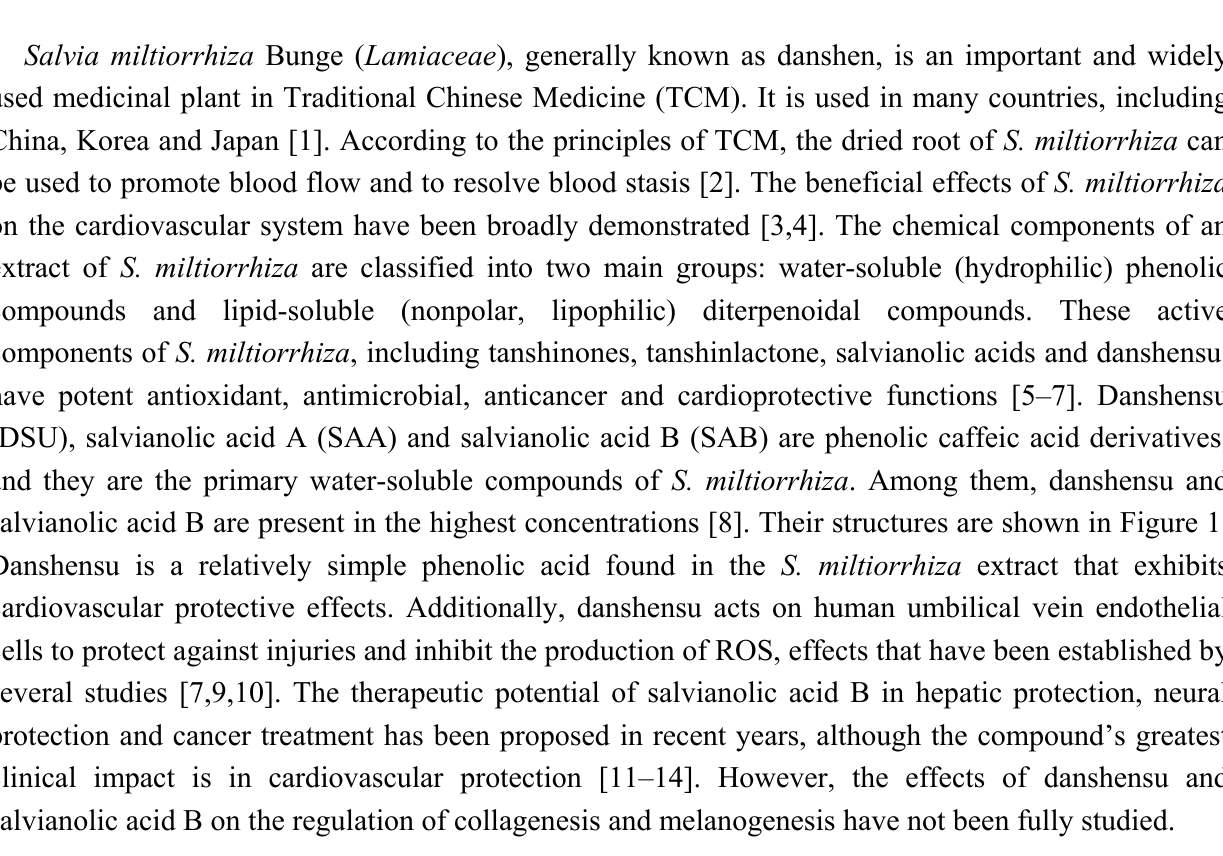
Figure 1. The chemical structures of ( A ) danshensu and ( B ) salvianolic acid